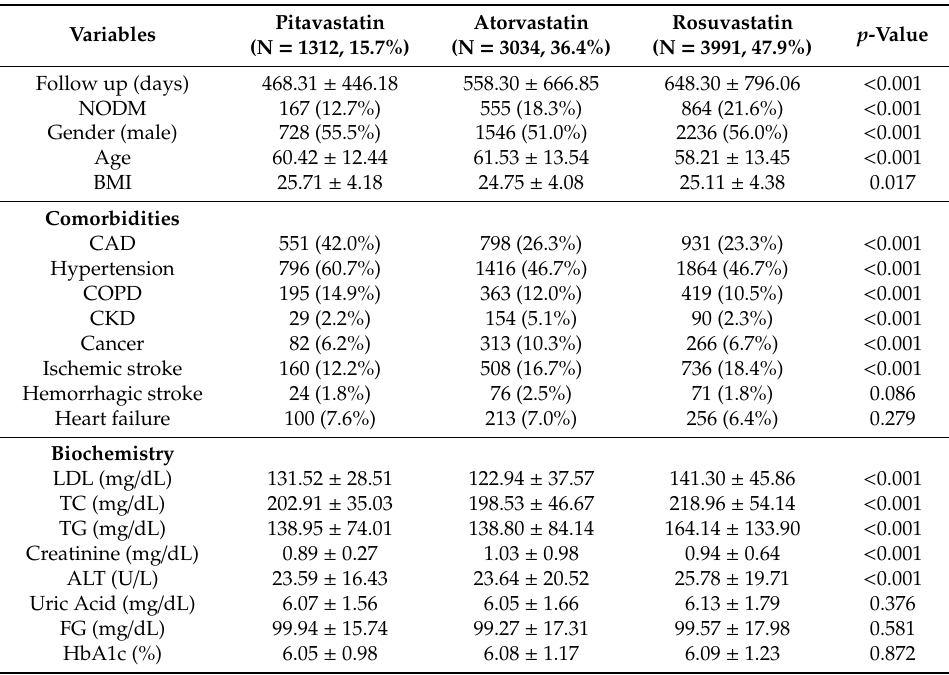
Table 1. Baseline characteristics of three statin groups.